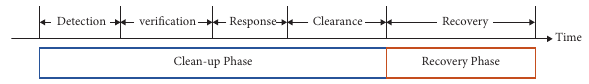
Figure 1: Two-phase traffic accident